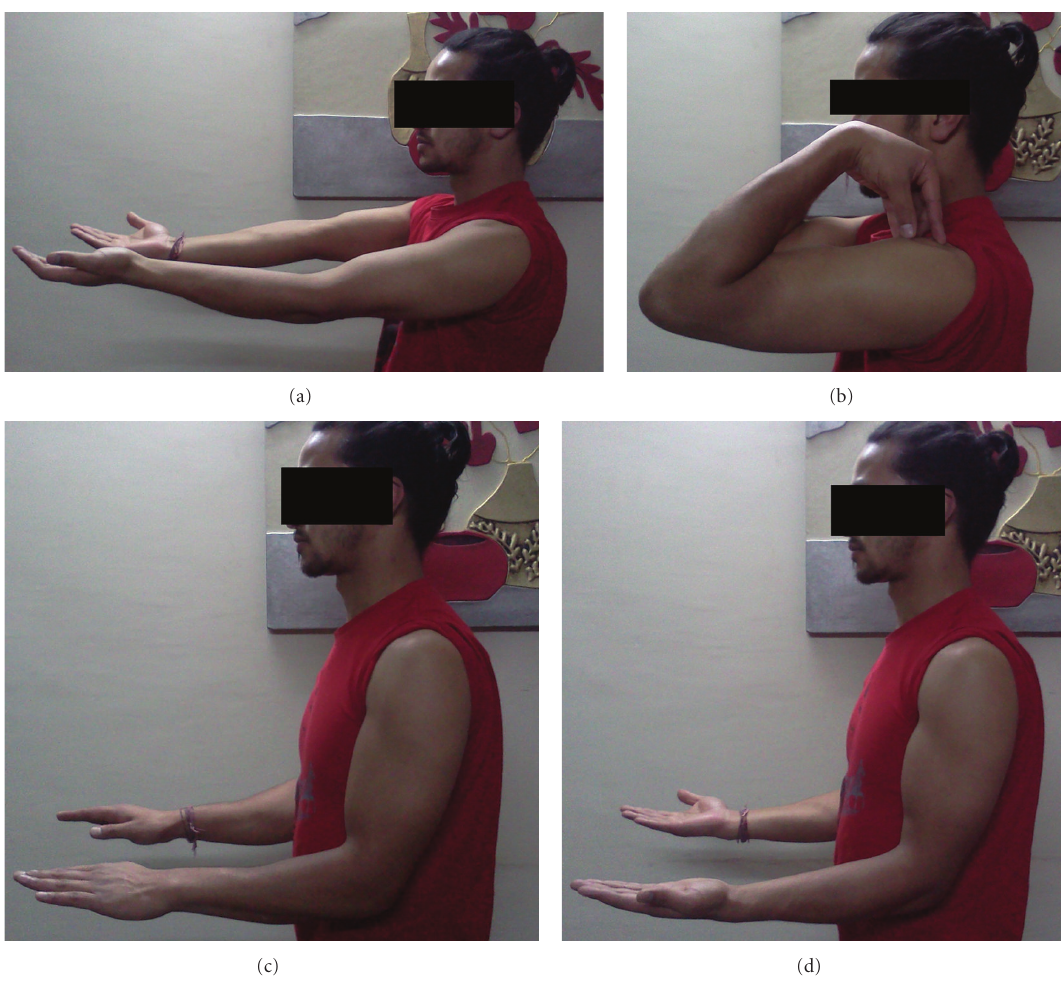
Figure 5: (a)–(d) Clinical photographs of the patient showing ROM at final